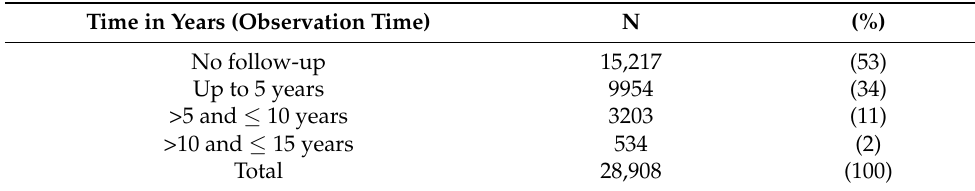
Table 4. Number of patients by the observation time between the first and last visits, from 1 June 2005, to 1 August 2019, while using periodontal